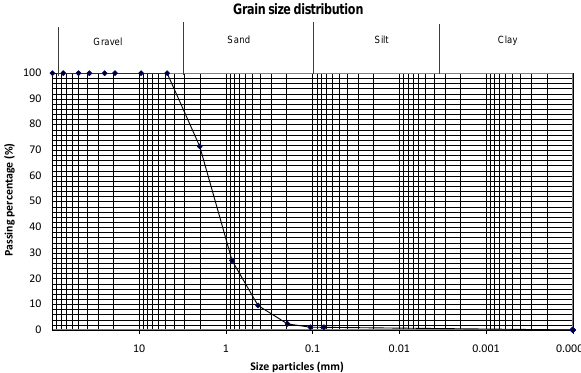
Table 1. Main initial properties of the mixture used.